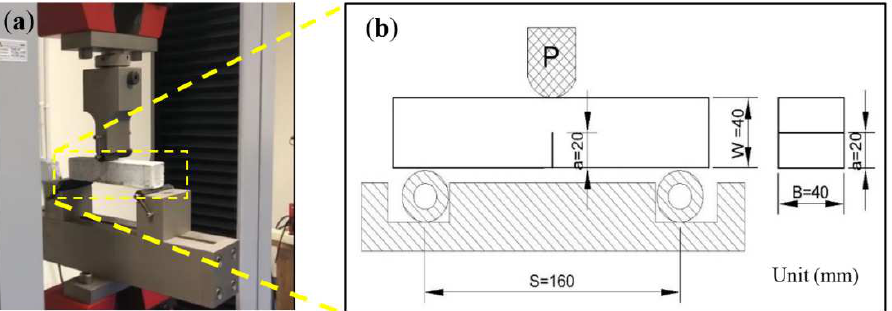
Figure 4. The setup of tools for the three-point bending test: ( a ) setup specimens and ( b ) schematic three bending test [15] with permission.